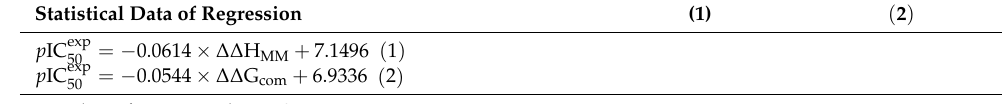
exp exp = − log of TCLs 10 IC 50 50